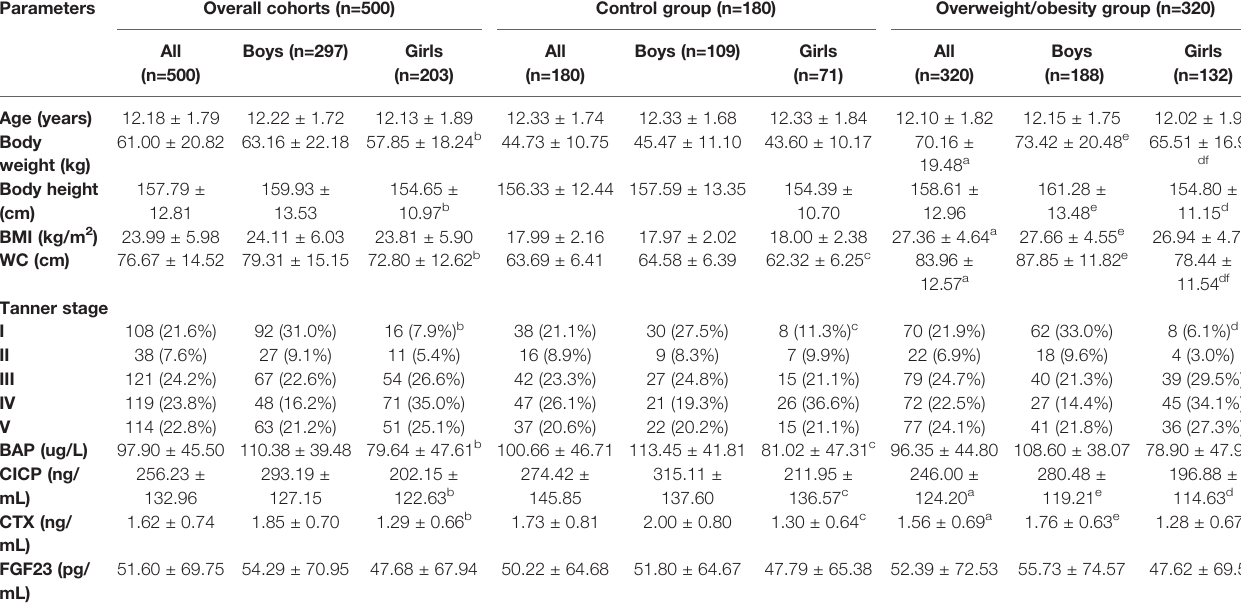
TABLE 1 | Comparison of subjects with and without overweight/obesity according to age, anthropometric measures, Tanner stage, and bone turnover markers of both sexes. Parameters Overall cohorts (n=500) Control group (n=180) Overweight/obesity group